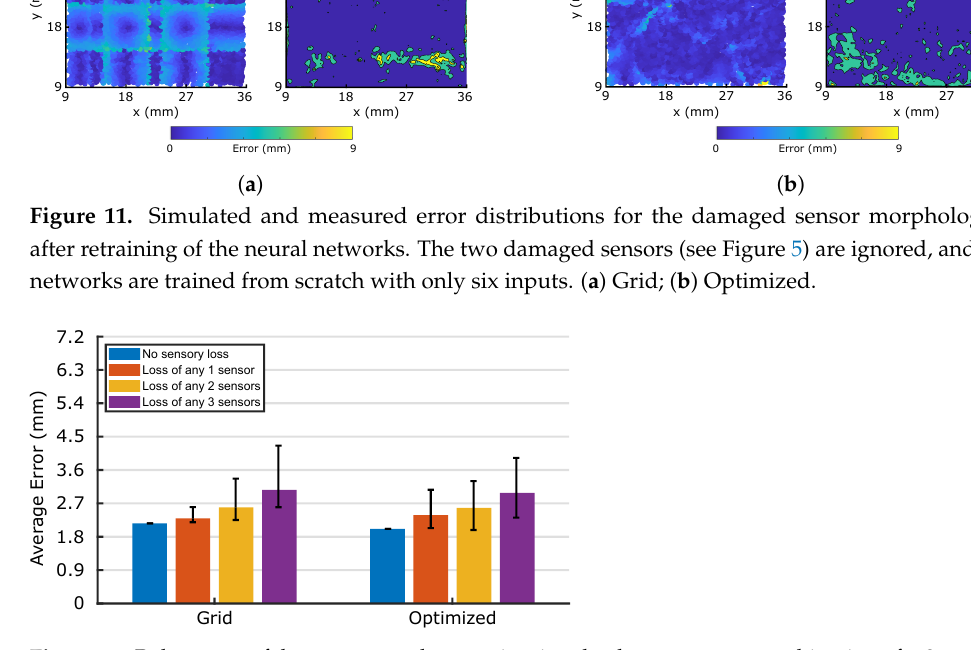
Figure 12. Robustness of the two networks experiencing the damage to any combination of ≤ 3 sensors ) possible combinations of losing n sensors: here, cases n = 0,1, 2,3 are after retraining. There are ( 8 n considered. For all combinations, a new network is trained to ignore the damaged sensors, the median localization error is calculated, and its range plotted